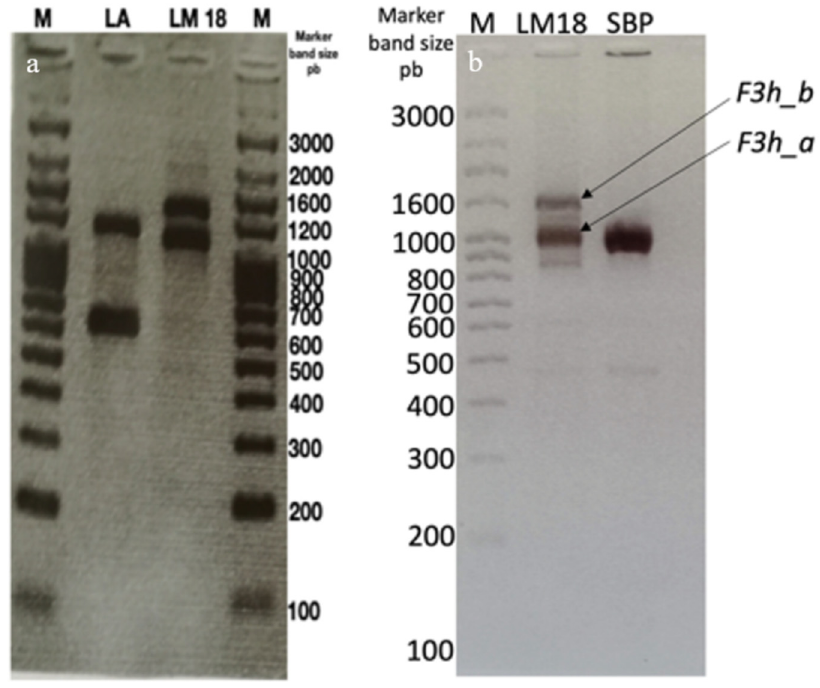
Figure 3. Amplification profiles obtained Lupinus angustifolius (LA; panel a ) and L. mutabilis (LM18 and SBP; panels ( a , b ) using the F3H primers 5 ′ GATTGGAGAGAGATTGTGACATA3 ′ (forward) and 5 ′ GGTTCAAGAATGCTGATCAC3 ′ (reverse) separated in 2% agarose gel. M- NZYDNA Lad- der V marker.